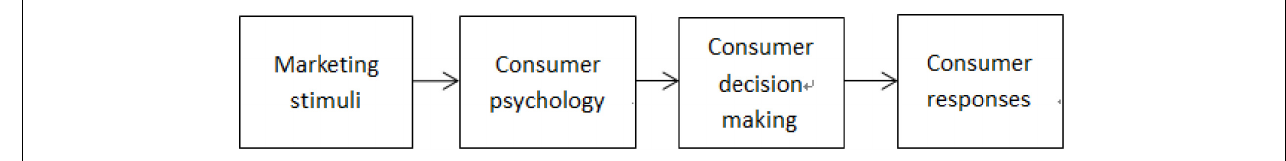
FIGURE 1 | Model of consumer behavior. Source: Kotler and Armstrong